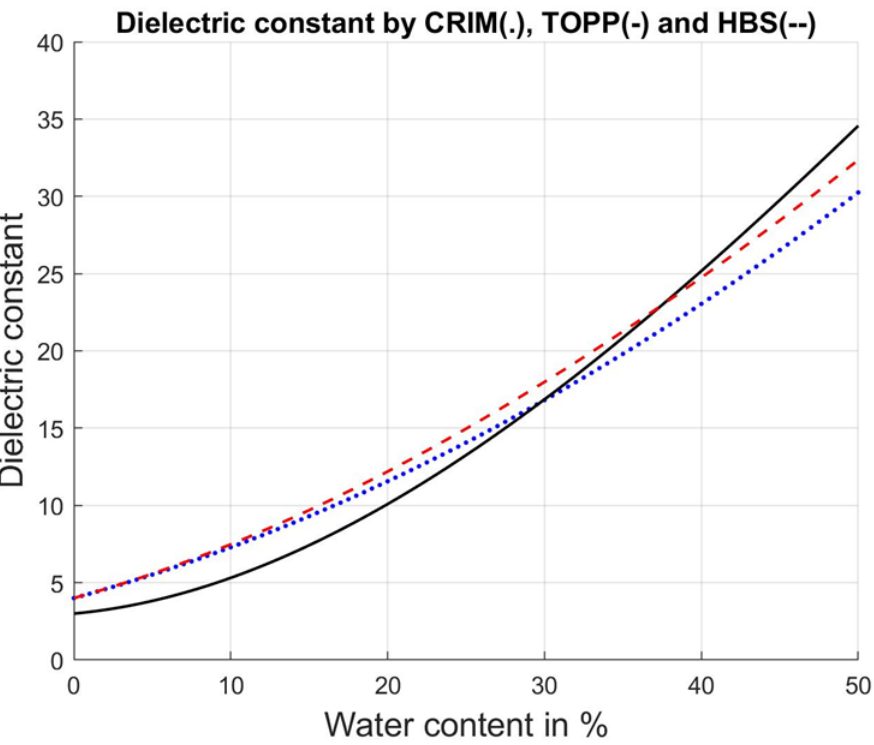
Figure A1. The dielectric constant increases with increasing water content. CRIM (blue dotted line), TOPP (black solid line), and HBS curves (red dashed line).